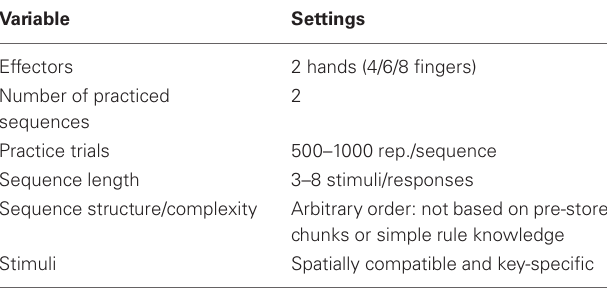
RSI = 0ms. Table 1 | Standard settings of the typical DSP